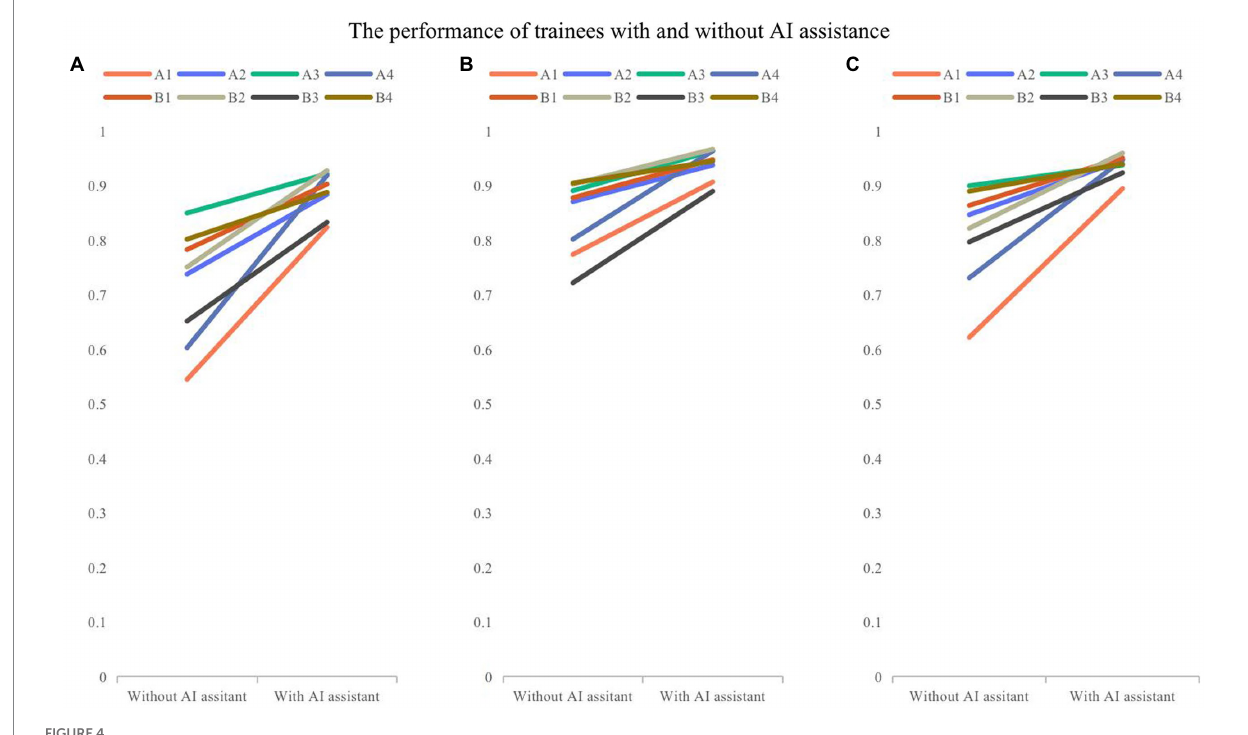
FIGURE 4 The comparison of performance of trainees with and without model assistance. (A) Overall accuracy; (B) the accuracy for recognizing layers; (C) the accuracy for classifying the normal and abnormal images. Folded-lines depict the changes in accuracy for each trainee with and without model assistance. Different colors represent different